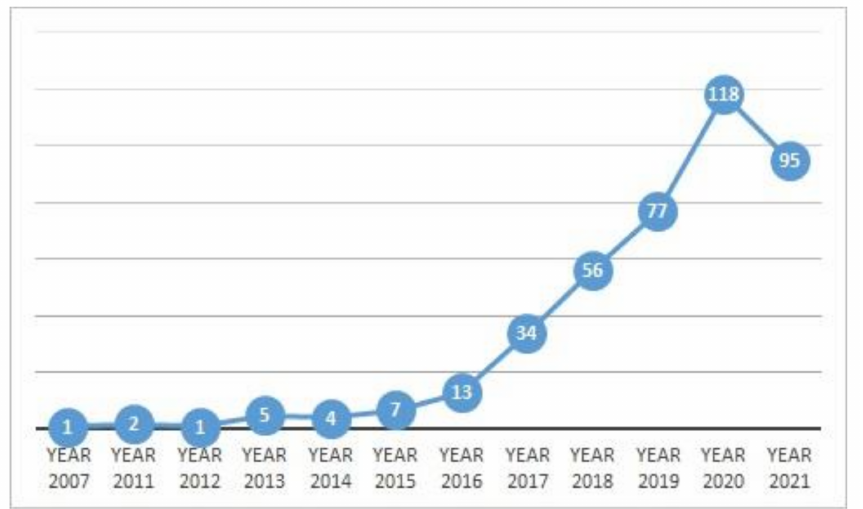
Figure 2. Increase in the number of articles matching the predefined keywords over the last 6 years; the PubMed search results were used to create this